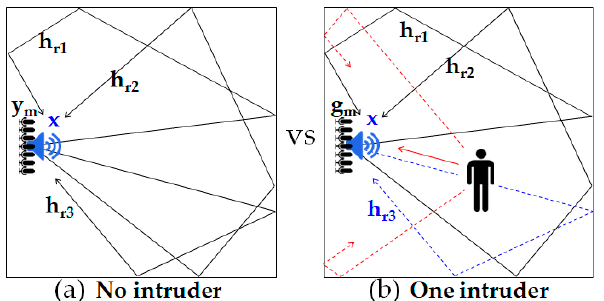
Figure 2. Scheme of sound field variation between ( a ) a reference scenario and ( b ) an event scenario: ( a ) Early reflection of room impulse response in a reference scenario without an intruder; ( b ) early reflection of room impulse response in an event scenario with an intruder.